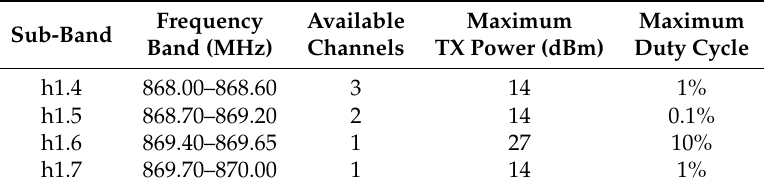
Table 1. EU863-870MHz ISM Band duty-cycle limitations.